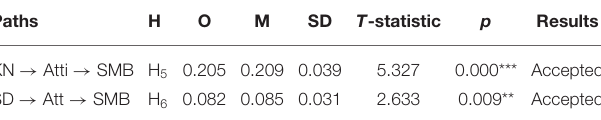
TABLE 8 | Indirect effects. Paths H O M SD T -statistic p